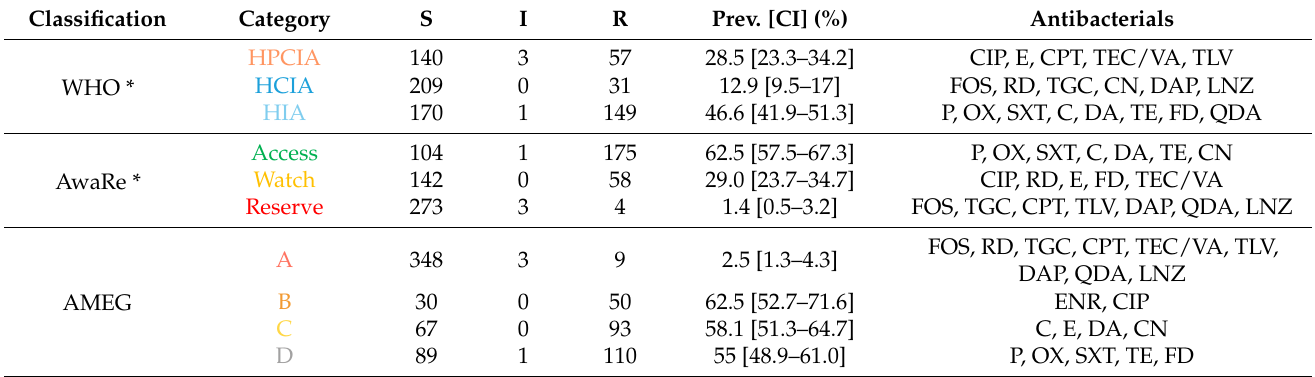
Table 2. Results of antimicrobial susceptibility tests aggregated by World Health Organization (WHO and AWaRe) and European Medicines Agency (AMEG) classifications of antibacterials. The absolute frequency of sensitive (S), sensitive to increased dosage (I), and resicannt (R) strains is reported along with the prevalence of R strains with 90% confidence intervals